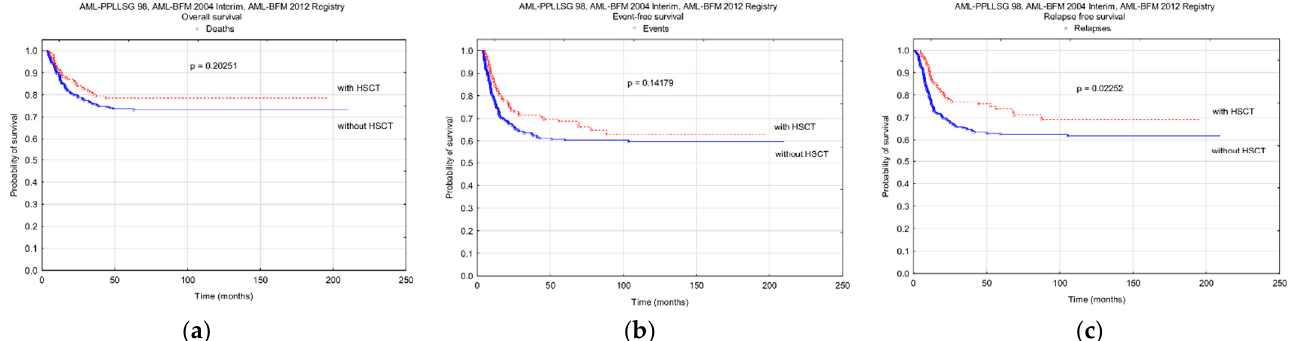
Figure 5. Probability of survival in patients treated with AML-PPLLSG 98, AML-BFM 2004 Interim, and AML-BFM 2012 Registry with and without hematopoietic stem cell transplantation (HSCT). The patients with event-free survival shorter than 4 months were excluded from the analysis: ( a ) overall survival; ( b ) event free survival; ( c ) relapse free survival.